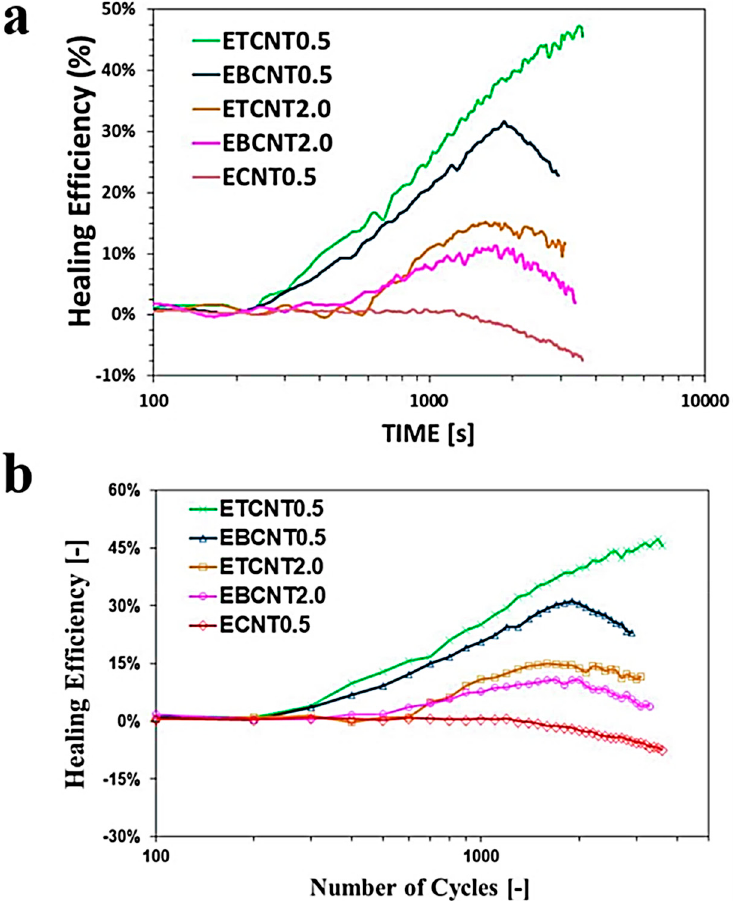
Figure 7. Self-healing efficiency for the nanocomposite samples containing non-functional CNT (ECNT 0.5 wt.%), thymine functional CNT (ETCNT 0.5 wt.%; ETCNT 2.0 wt.%) and barbiturate functional CNT (EBCNT 0.5 wt.%; EBCNT 2.0 wt.%) as function of: ( a ) time and ( b ) number of cy-